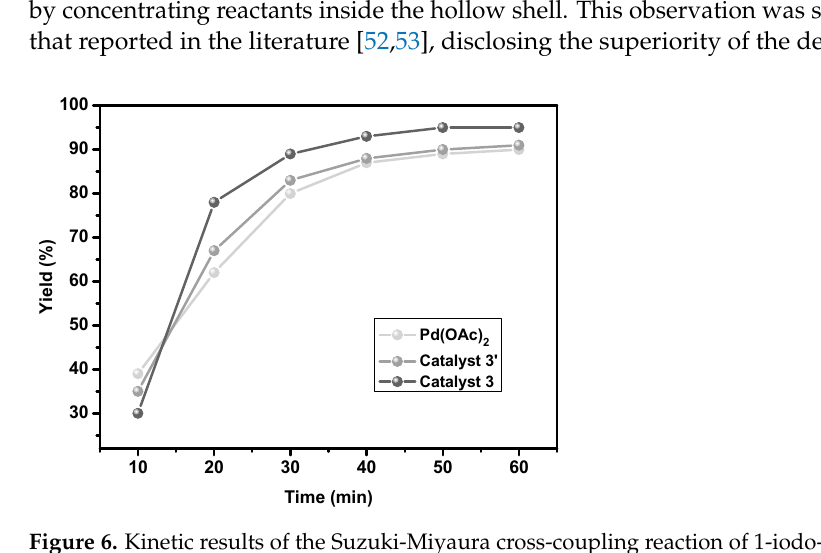
Figure 6. Kinetic results of the Suzuki-Miyaura cross-coupling reaction of 1-iodo-4-methoxybenzene and phenylboronic acid.